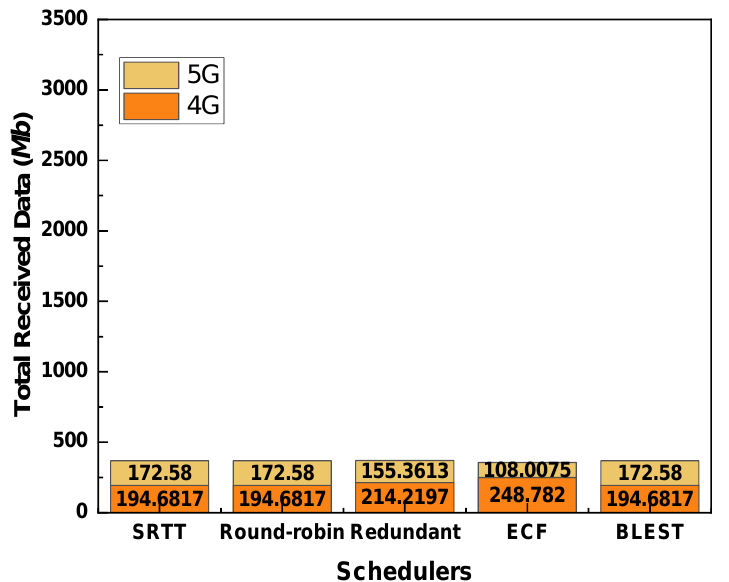
Figure 10. Performance of the tested MPTCP schedulers in terms of total received data for wVegas as a CCA.